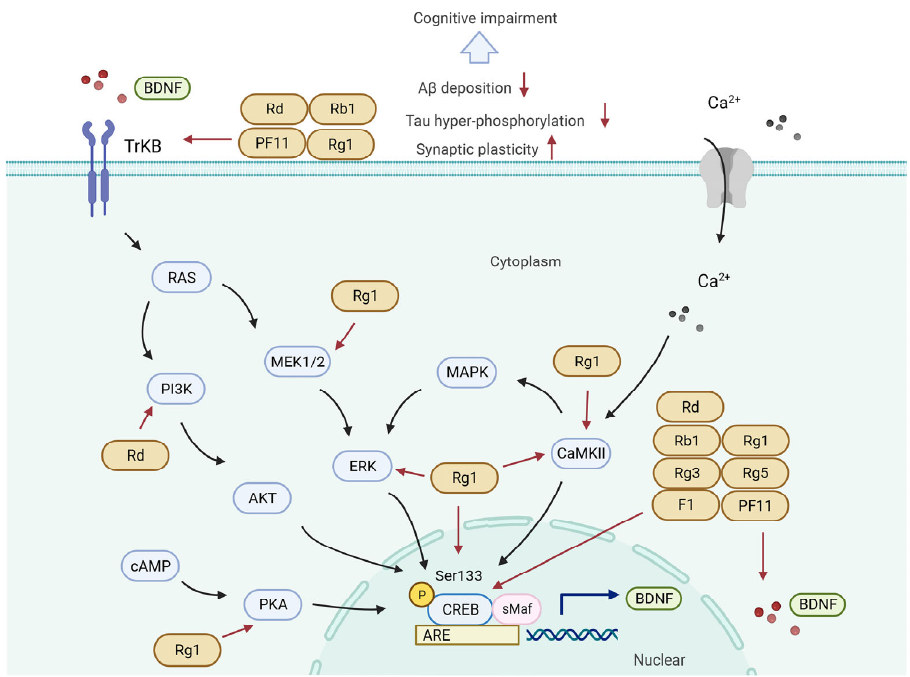
Figure 4. Molecular mechanisms of regulating CREB/BDNF signaling pathway by ginsenosides in treating cognitive impairment in the pathological model. CREB/BDNF signaling pathway can be activated by ginsenosides in multiple ways: ( 1 ) Rd, Rb1, PF 11, and Rg1 promote the expression of TrKB. ( 2 ) Rg1 and Rd increase the expression of MEK1/2 and PI3K, respectively. ( 3 ) Rg1 activates ERK, PKA, CREB, and CaMKII. ( 3 ) Rd, Rb1, Rg1, Rg3, Rg5, F1, and PF11 can promote both CREB and BDNF. All ginsenosides play a positive role in stimulating key factors in CREB/BDNF pathway to further improve synaptic plasticity and decrease A β deposition and tau hyperphosphorylation.